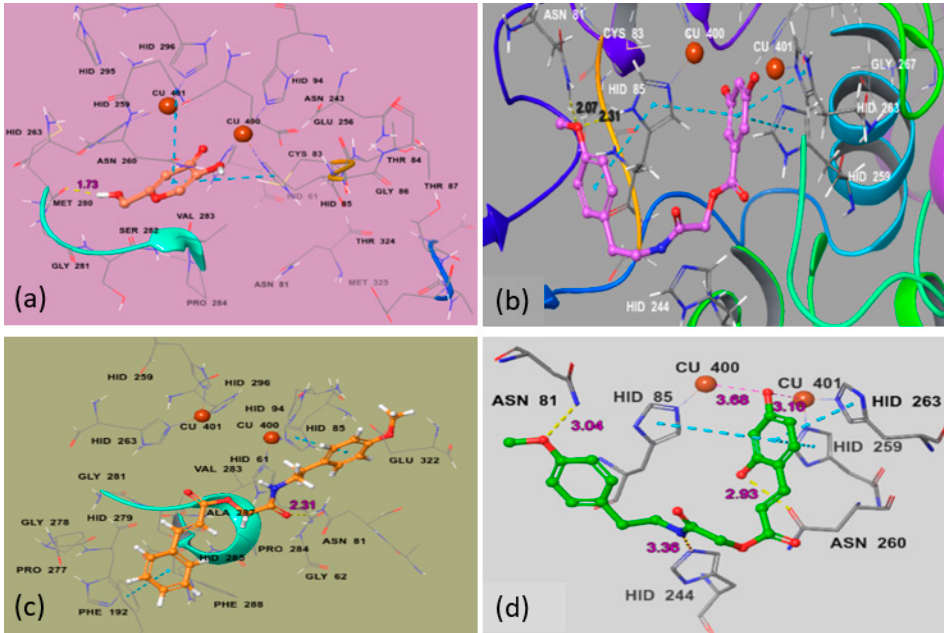
Figure 4. Ball and stick representation of the docking pose of ( a ) Kojic acid (a-brick red), 2-((4-methoxyphenethyl)amino)-2-oxoethyl 3,5-dihydroxybenzoate (Ph5), ( b )-magenta, 2-((4- methoxyphenethyl)amino)-2-oxoethyl cinnamate (Ph6), ( c )-yellow and 2-((4-methoxyphenethyl)amino)-2-oxoethyl( E )-3-(2,4-dihydroxyphenyl)acrylate (Ph9), ( d )-green in the active site of mushroom tyrosinase (2Y9X). The inhibitor binds in the active site closer to the Cu 2+ . Amino acid residue forming the binding pocket of the tyrosinase is labeled in stick representation. Cu 2+ ions are shown in brown and labelled. Table 3. Docking energies of synthesized amide derivatives (Ph1–Ph10) against mush- room tyrosinase, PDB ID 2Y9X.